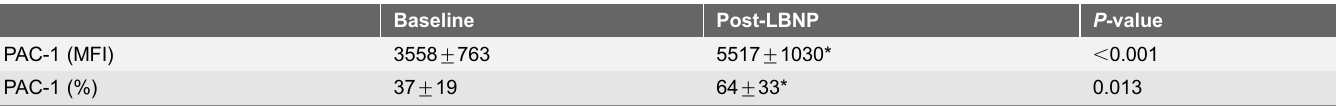
Table 1. Platelet activity determined by flow cytometry before and 5 min after lower body negative pressure (post-LBNP) was ceased because of presyncopal symptoms. Baseline